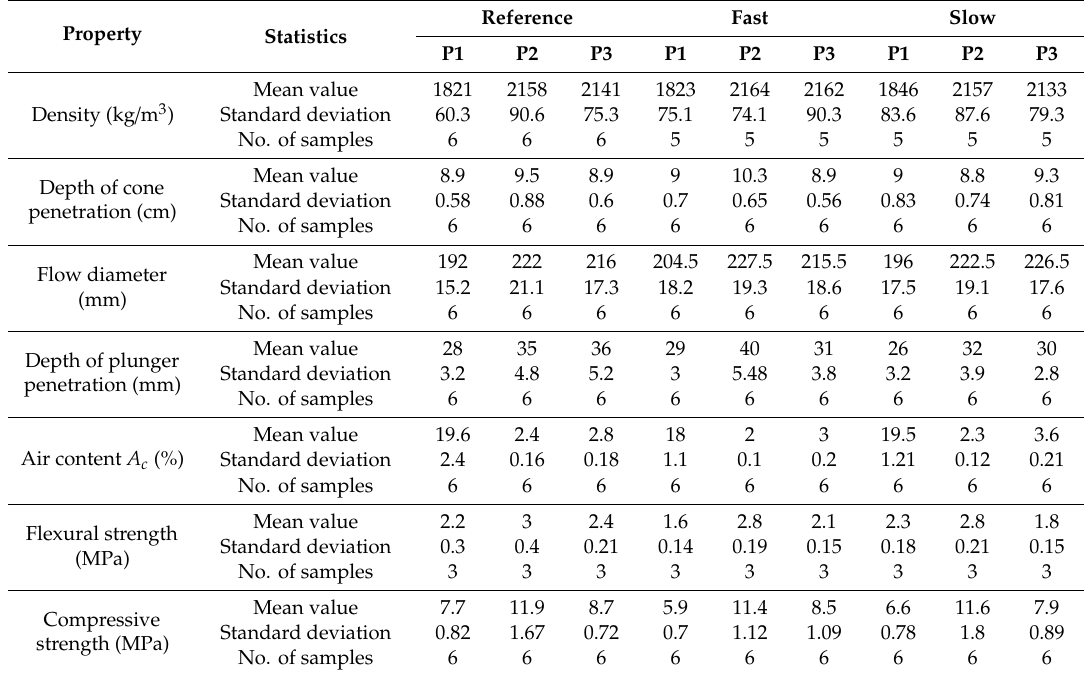
Table 17. Results of tests of the influence of mixing intensity on properties of plaster.